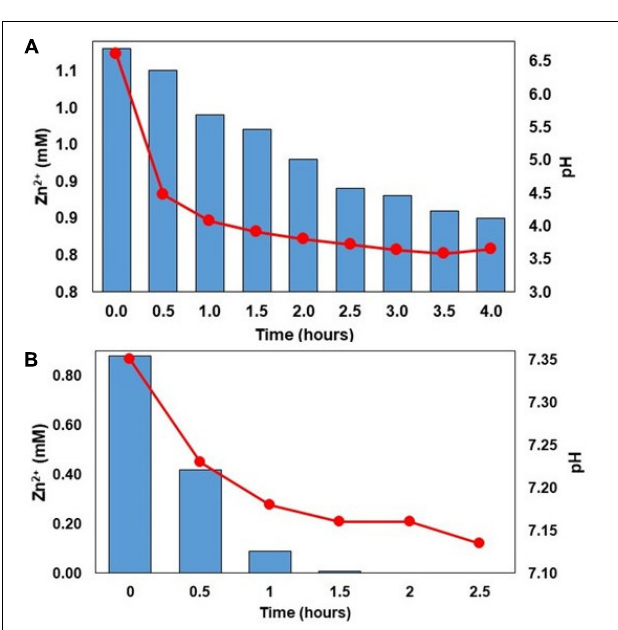
FIGURE 3 | Changes in concentrations of soluble zinc (bars) and pH (lines) in off-line vessels containing synthetic mine water (A) and actual MIW (B) from Minsterley Brook, contacted with H 2 S generated by the